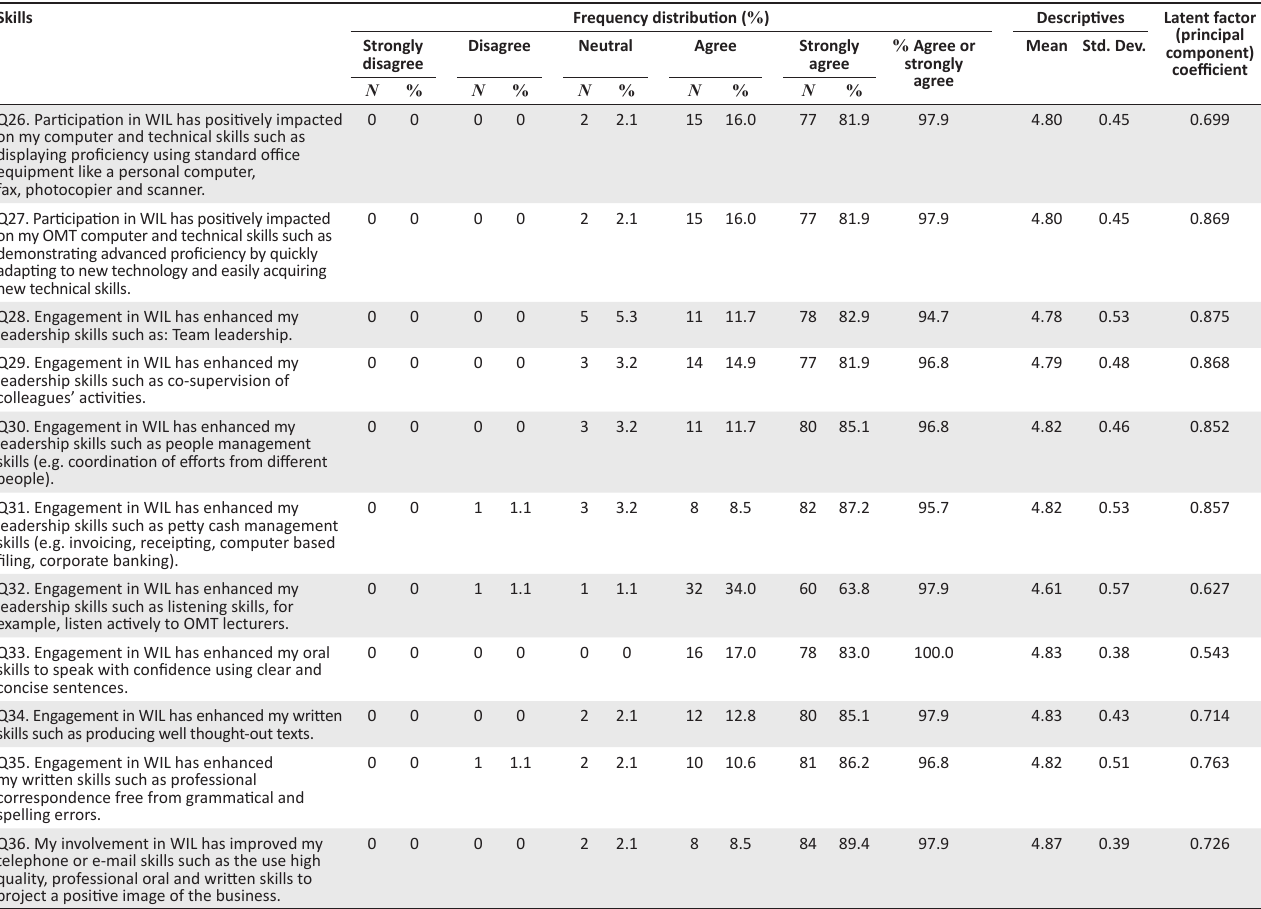
TABLE 5: Skills learning. Skills Frequency distribution ( % ) Descriptives